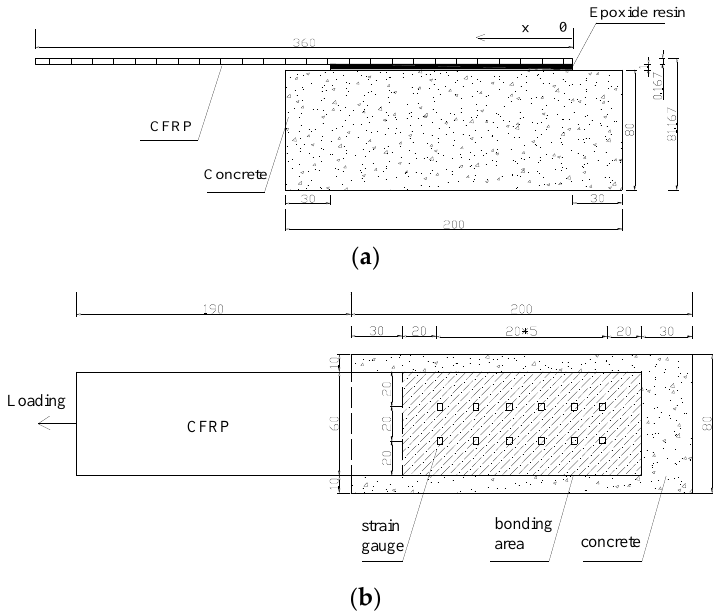
Figure 2. Layout of strain gauges in bonding area: ( a ) side view; ( b ) top view.